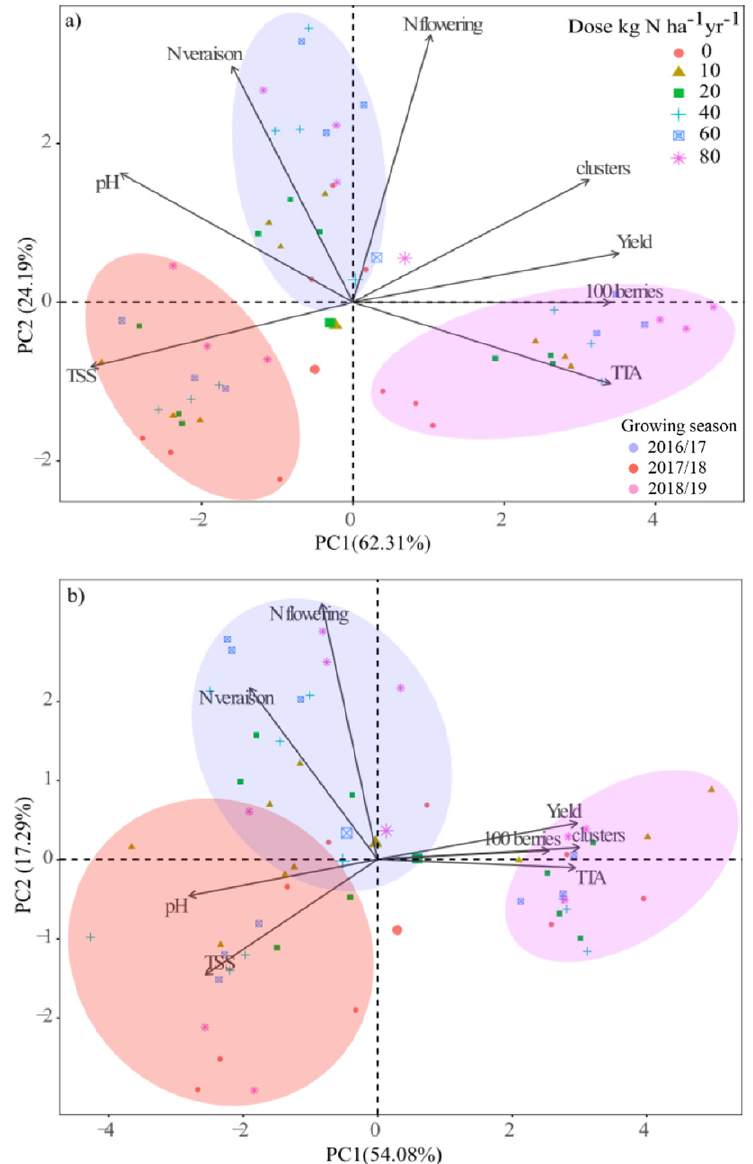
Figure 7. Relationship between principal component 1 (PC1) and principal component 2 (PC2) for response variables analyzed in field experiments with ‘Chardonnay’ ( a ) and ‘Pinot Noir’ ( b ) cultivars subjected to N fertilization in the soil, during 2016/17, 2017/18, and 2018/19.